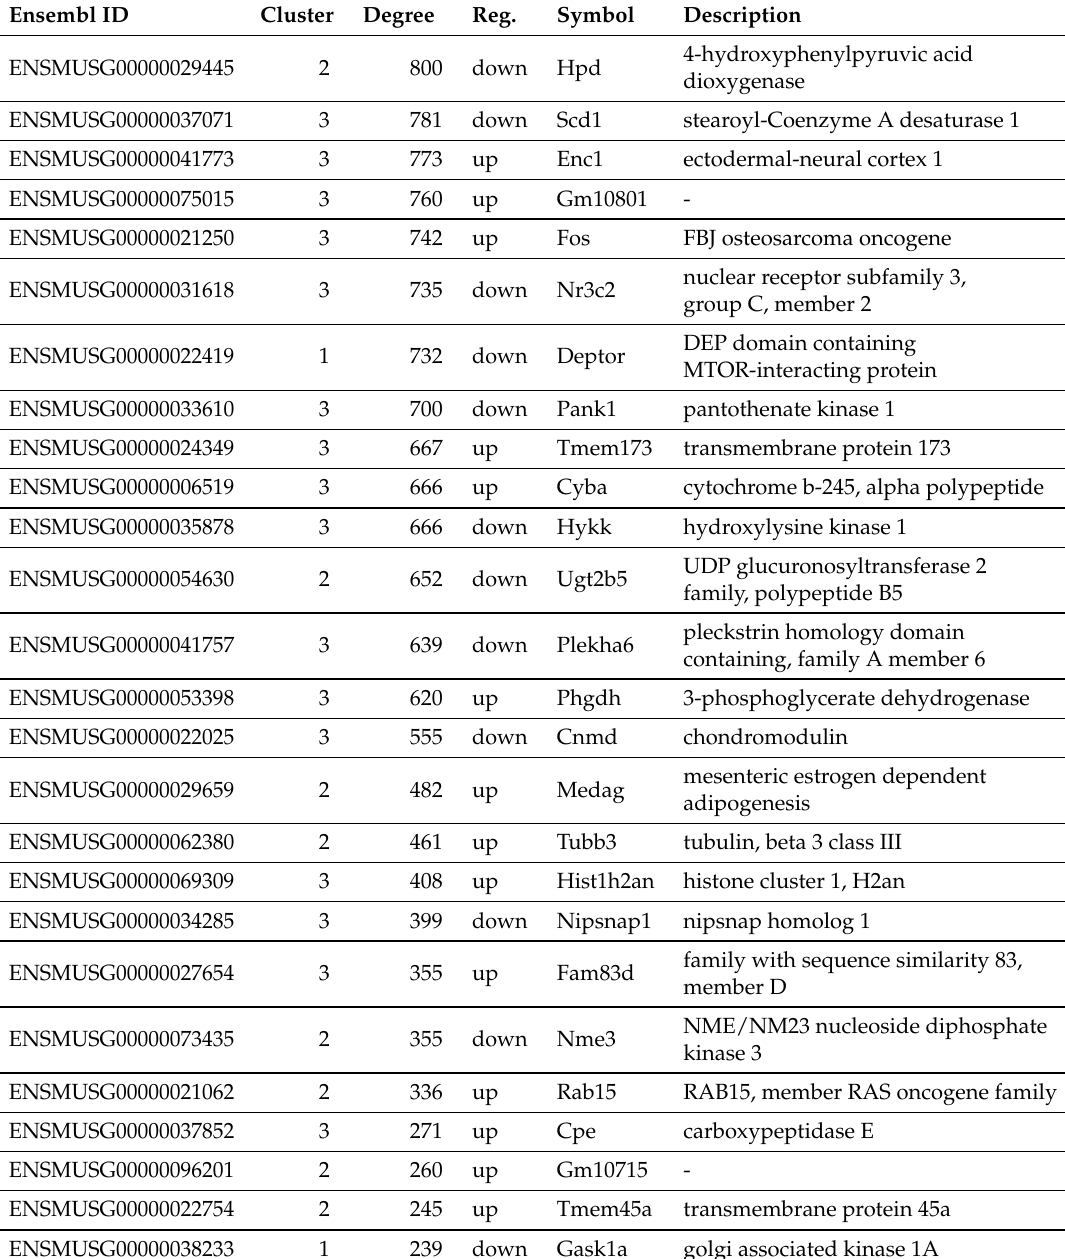
Table A3. Hubs identified in the network reconstructed from liver Ly6E ∆ HSC samples. Degree cutoff: 39. Reg.